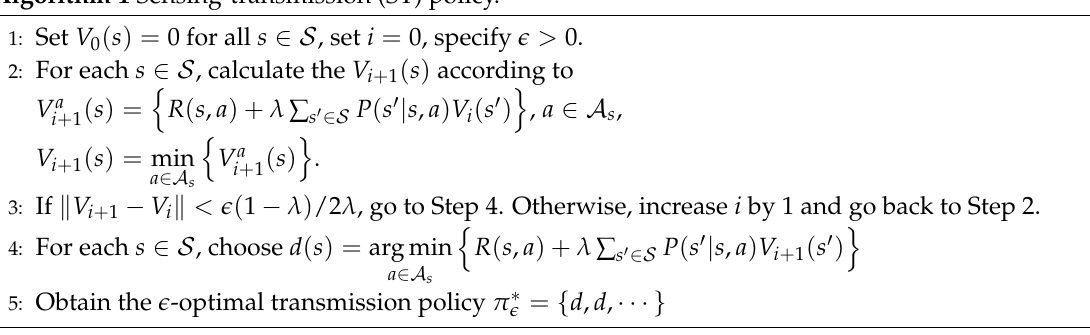
Algorithm 1 Sensing-transmission (ST)